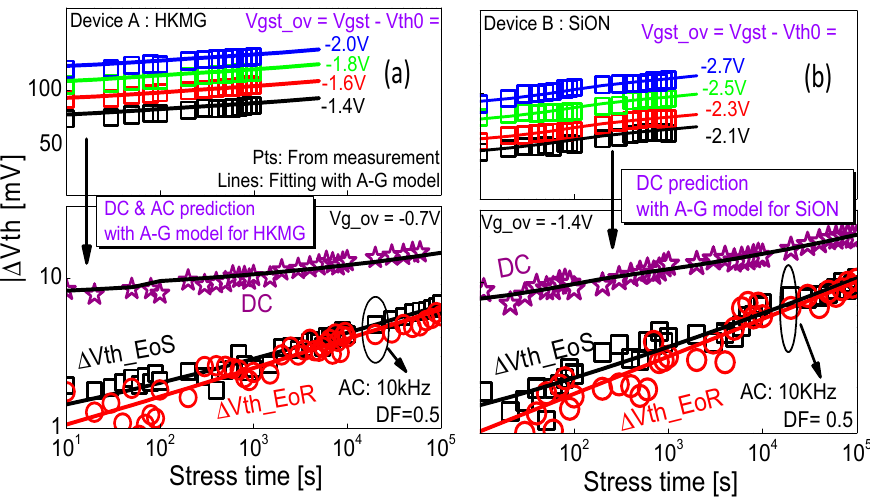
Figure 33. Prediction of NBTI by the AG model for a high-k/SiON stack ( a ) and SiON ( b ). The model parameters were extracted by fitting the accelerated test data in the top panels. They were then used to predict the NBTI at lower biases and for a longer time in the bottom panels [36].